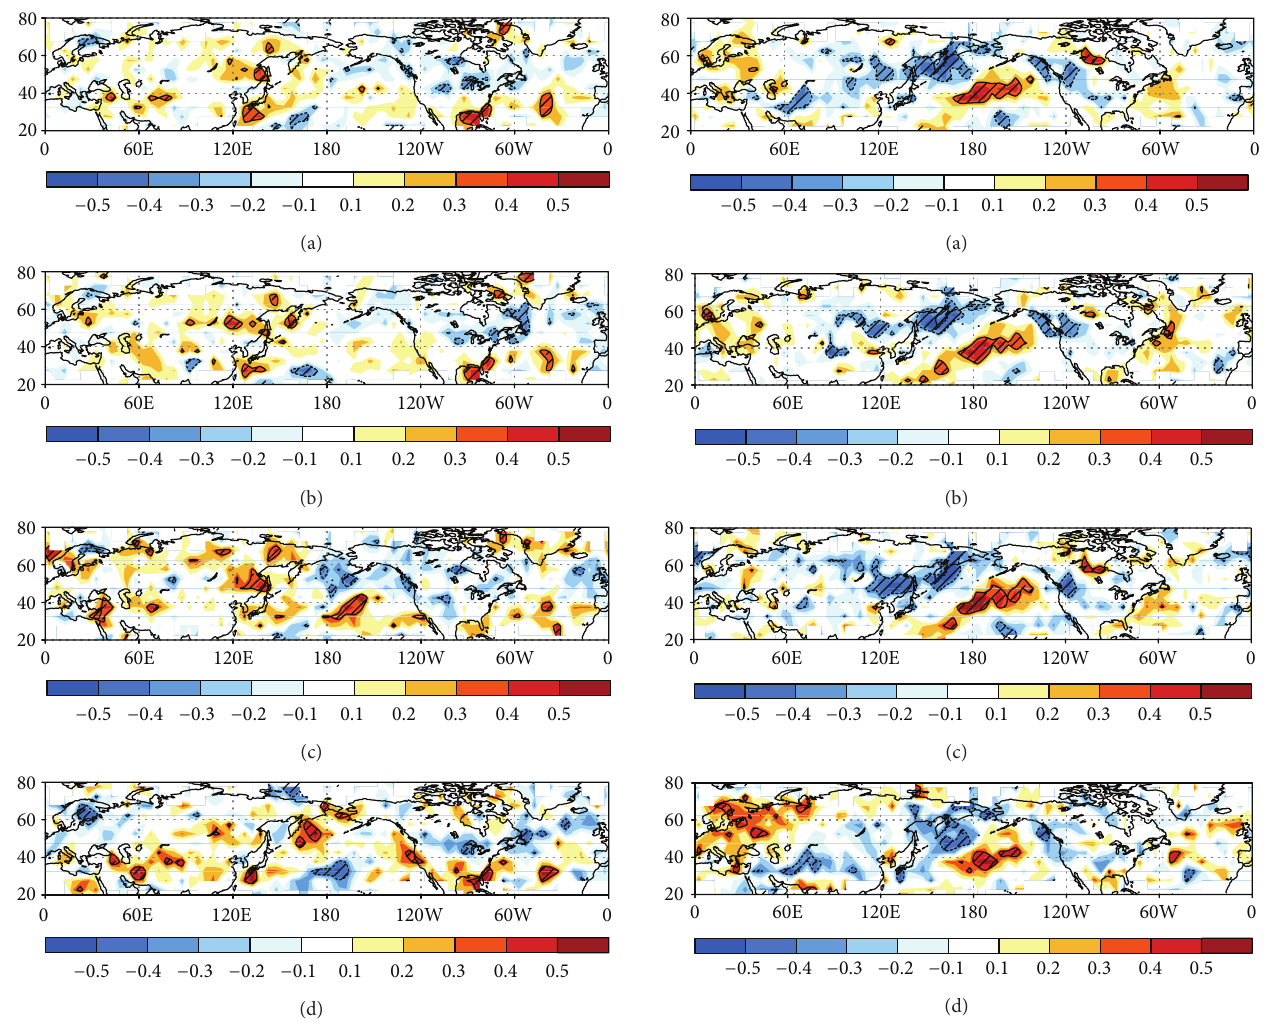
Figure 6: Partial correlation coefficient for JFM cyclone fre- quency versus PNA (excluding ENSO and NAO). Correlation (shaded). 2-tailed 90% significance (hatched) for (a) NCEP1 5801, (b) ERA40 5801, (c) NCEP1 7910, and (d) NCEP1 5078.